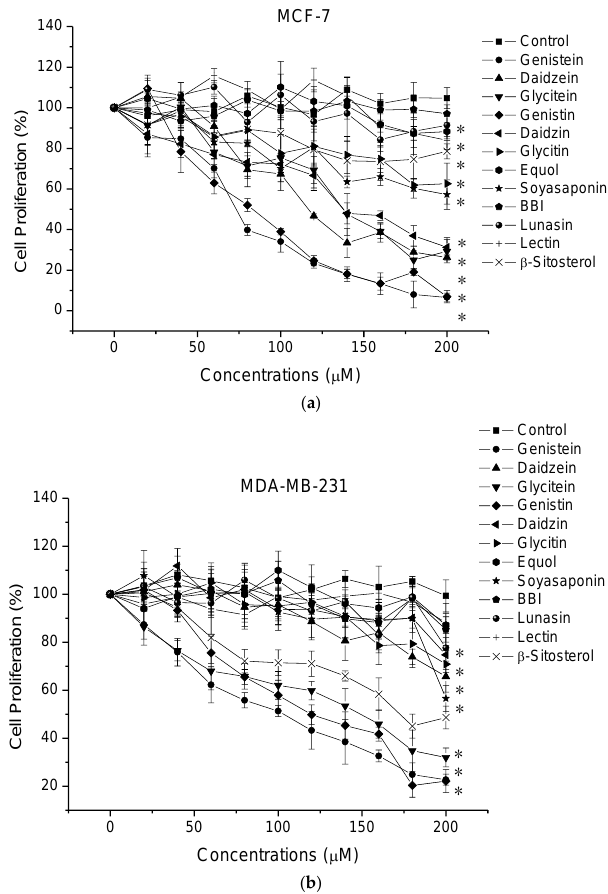
Figure 1. Percent inhibition of MCF-7 ( a ) and MDA-MB-231 ( b ) human cancer cells proliferation by 12 anticarcinogens from soybean. Cells were respectively treated with different concentrations (0– 200 μM) of 12 samples. Data are presented as mean ± SD. * indicates a significant difference compared to the control in cell proliferation assay at concentration of 200 μM ( p < 0.05). Due to obvious anti-proliferative activity of compounds from natural plants, the dietary modification is thought to be an alternative strategy to prevent and reduce the risk of breast cancer [10]. However, the effective doses of these compounds can barely be achieved by oral consumption. Nowadays, the synergistic effect generated from drug combination has attracted great attention due to the advantage of increased anti-cancer effect, lesser drug dose, reduced side effects. To further investigate whether there is a synergistic effect of anticarcinogens from soybean, samples showing